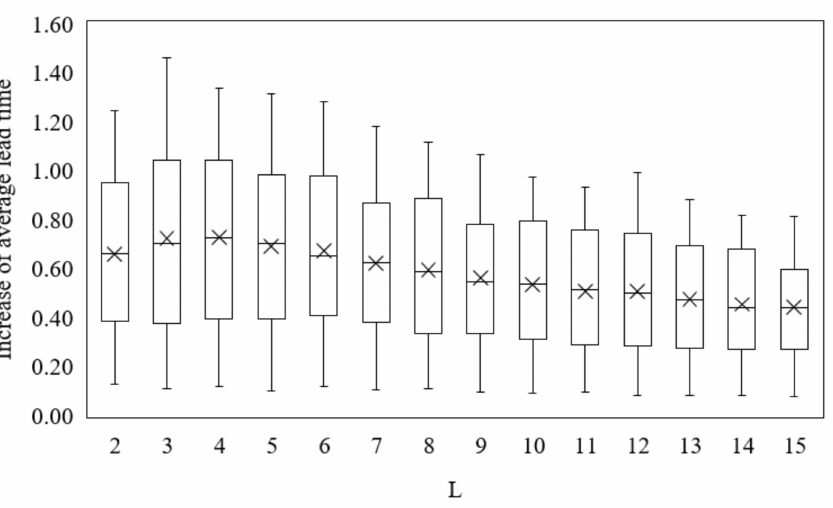
Figure 9. Box and Whiskers plot for total increase of average lead time due to consolidation.